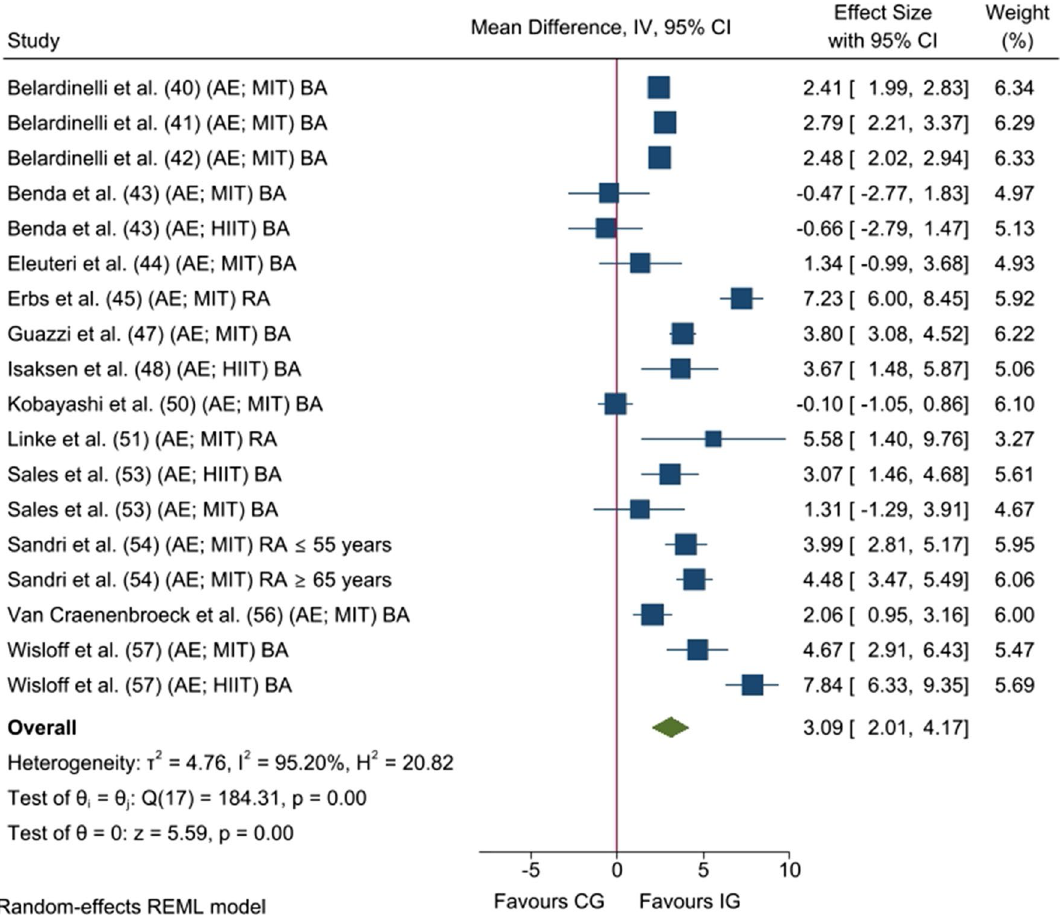
Fig. 2 Forest plot of mean differences between exercise‑based cardiac rehabilitation and control group for relative flow‑mediated dilation. AE, aerobic exercise; BA, brachial artery; CG, control group; CI, confidence interval; HIIT, high‑intensity interval training; IG, intervention group; IV, inverse variance; MIT, moderate‑intensity training; and RA, radial artery